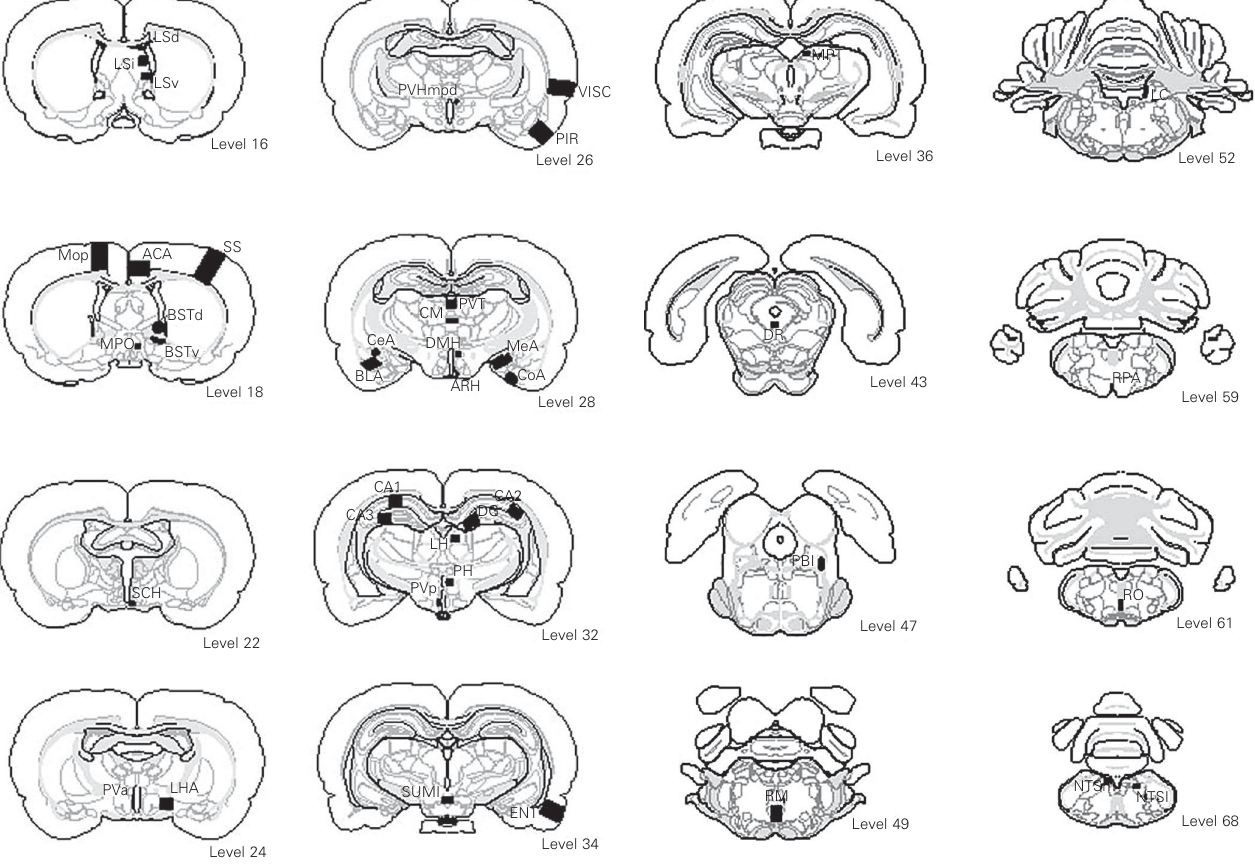
Figure 2. Diagrams illustrating the templates and relative sizes of the different brain areas subjected to counting of Fos-immunoreactive cells. The levels were based on Swanson’s Stereotaxic Atlas of the Brain (12). Abbreviations are shown in the legend to Table